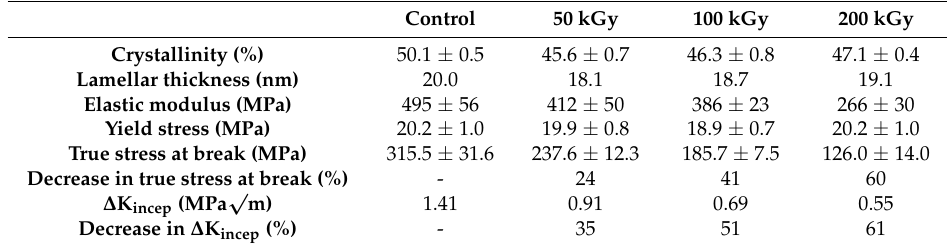
Physical properties and fatigue crack propagation data for a set of standard and crosslinked/remelted UHMWPE (GUR 1050), at increasing gamma radiation doses. All crosslinked samples were remelted at 170 ◦ C for 4 h and subsequently annealed at 125 ◦ C for 2 days. Adapted from [60] with